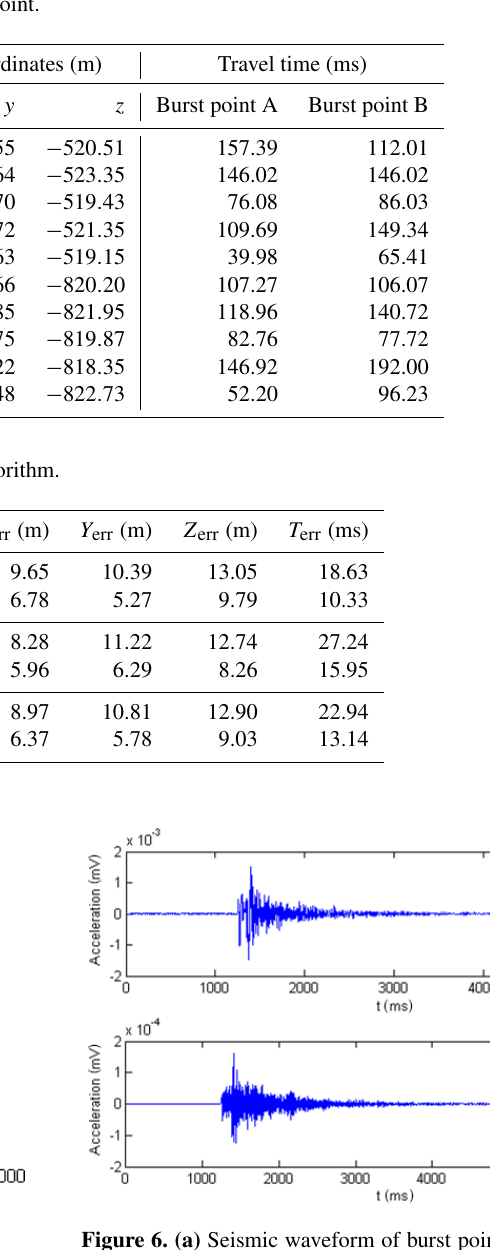
Table 4. Geophone coordinates and travel time from the burst point.